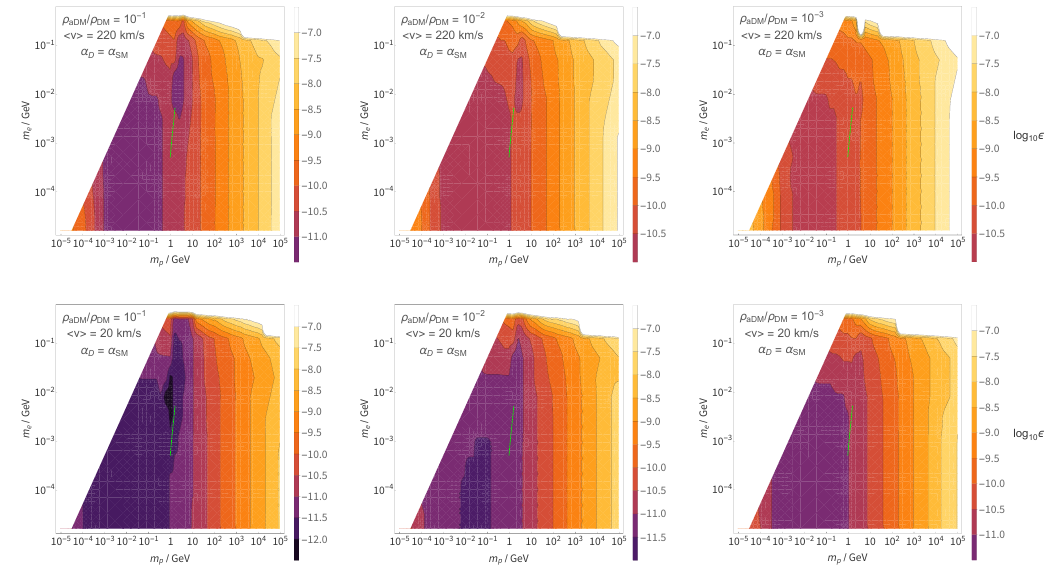
Figure 5 . Colored contours show constraints on the dark photon mixing (cid:15) in aDM for α D = α em ≈ 1 / 137 as a function of dark proton and dark electron mass. The top row shows constraints assuming h v i = 220 km/s (halo-like), while the bottom row shows constraints for h v i = 20 km/s (disk-like). From left to right the columns correspond to dark matter density fractions of ρ = 10 − 1 , aDM /ρ DM 10 − 2 , and 10 − 3 . The dashed green line shows how the dark electron and proton masses are correlated in the Mirror Twin Higgs scenario for v = 1 – 10 B /v A